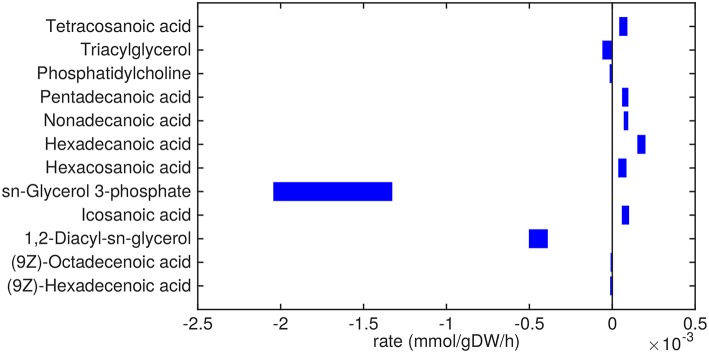
Predicted lipid uptake and secretion rates by Mtb in the host. Predicted ranges of uptake and secretion rates (mmol gDW−1 h−1) of lipids by Mtb inside the host are indicated by blue bars. Negative values denote uptake and positive values denote secretion.